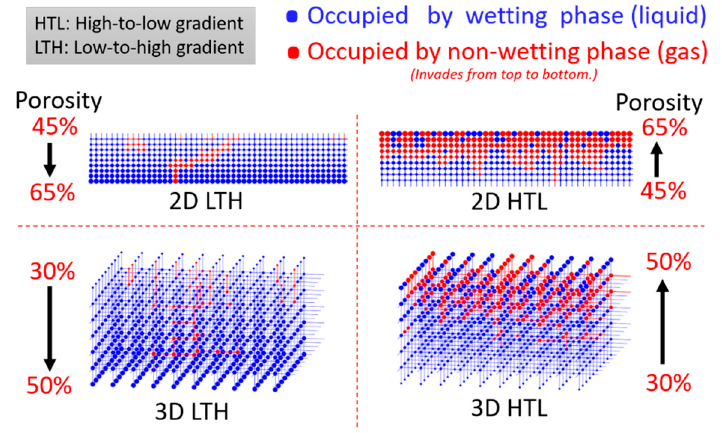
Figure 7. Overview of the different invasion patterns obtained from the simulation of hydrophilic drainage in 2D and 3D pore networks with vertical gradients of pore size and porosity.